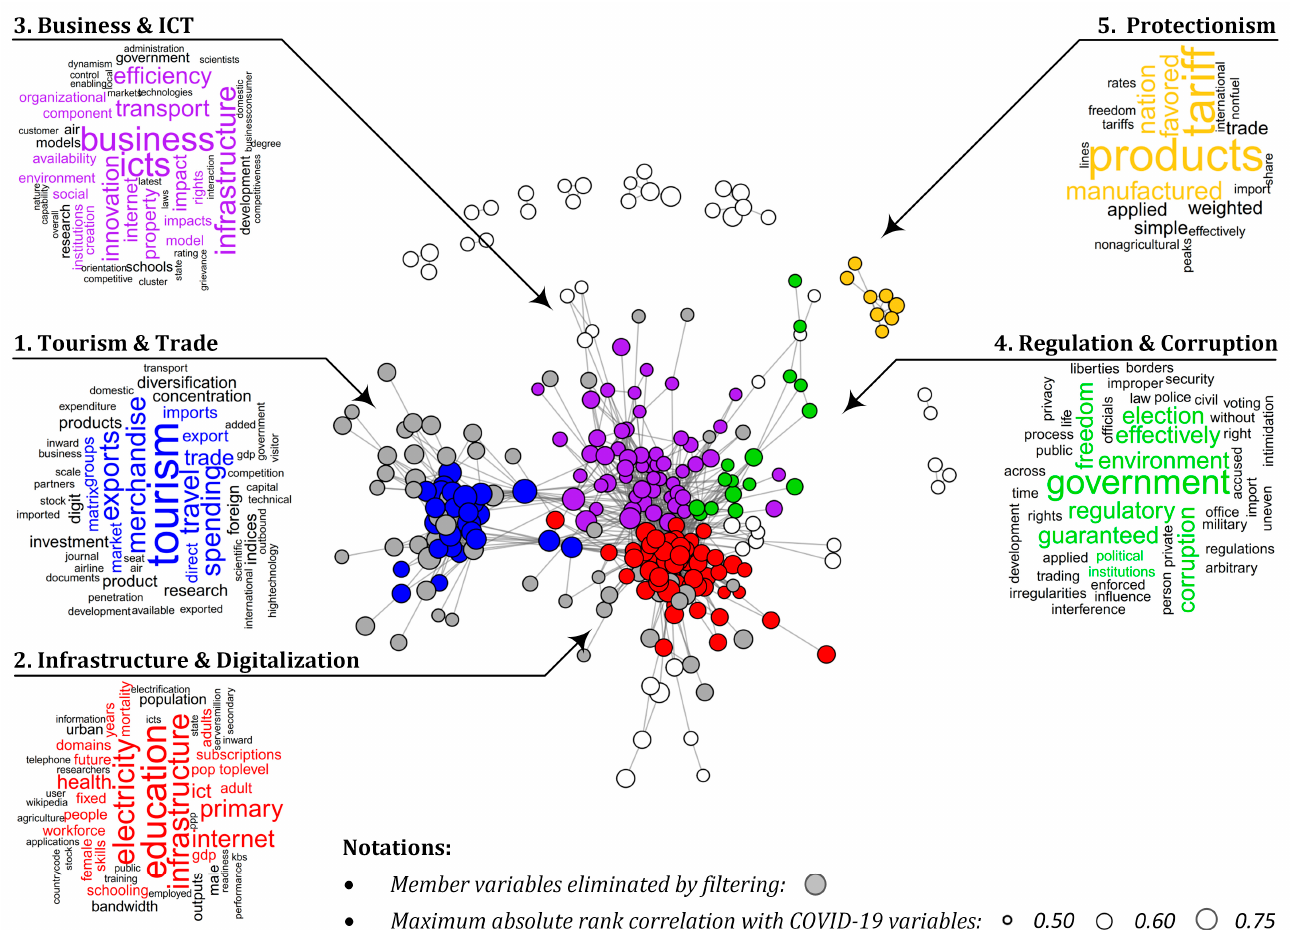
Figure 2. Detected communities. The five communities of correlated GovData360 and TCdata360 indicators. Indicators are denoted by vertices and the edges representing the strong correlations among them. The interpretation of communities is supported by word clouds generated on the basis of the names of member indicators. Note that the applied method may not create purely separable communities, so the same words can occur in different word clouds. This can also occur if the same word appears in the names of significantly different